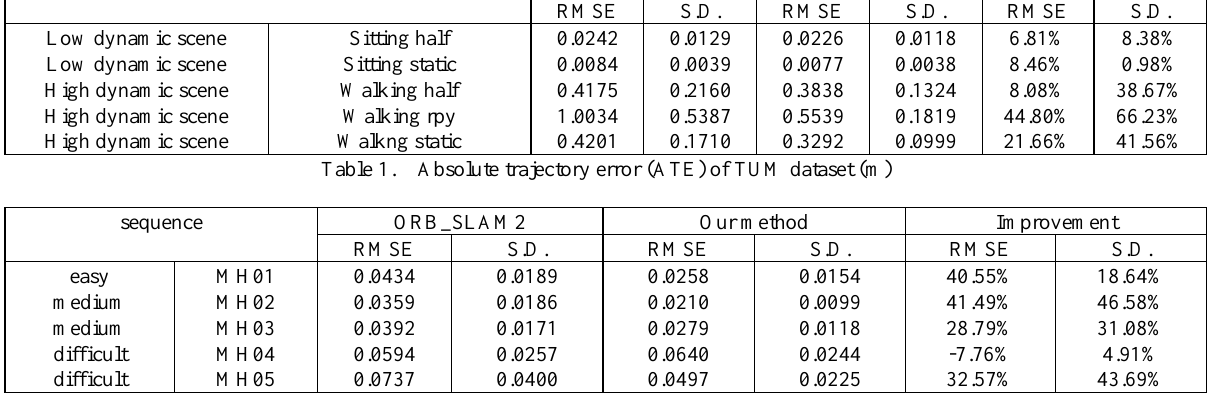
Table 2. Absolute trajectory error (ATE) of EuRoC